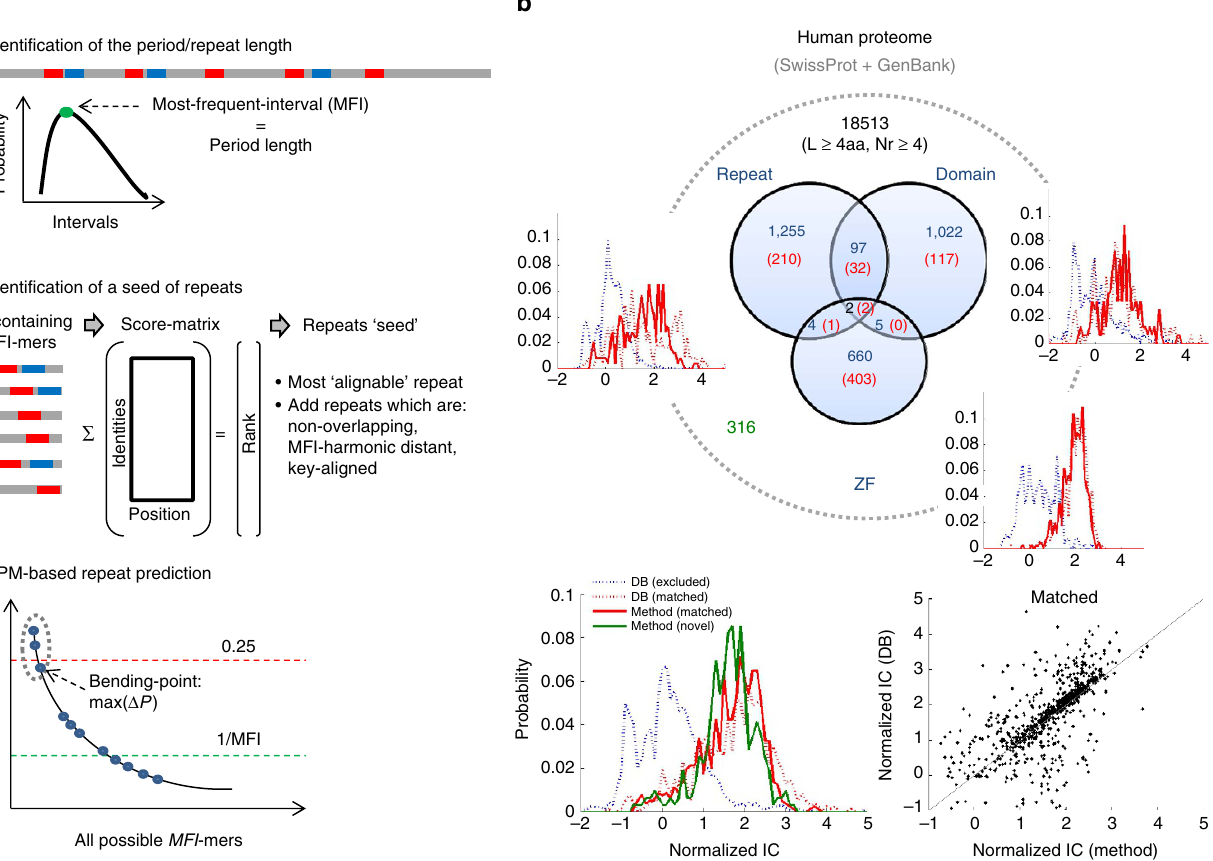
Figure 1 | Three steps computational pipeline to extract repeats and its validation. ( a ) First, the period length (L) of repeats is inferred from the most frequent interval (MFI) of frequent triplets (FT). Second, a seed of repeats is identified by aligning all possible k -mers ( k ¼ L ¼ MFI) that contain FT s , transforming the alignment into a scoring matrix, and selecting valid top ranked MFI-mers. Third, a probability position matrix (PPM), Q, is built from the seed over a background, B, to predict additional repeats. See Methods and Supplementary Methods for more details. ( b ) A set of 18513 canonical proteins from Swissprot that match information in GenBank, containing the corresponding coding DNA, are analysed. Swissprot annotates 3,045 proteins (blue numbers) which contain at least four repeats of length Z 4aa, assigned to 3 distinct classes (Repeats, Domains, Zinc-fingers). The method extracts a subset of 765 proteins (red) and identifies 316 novel ones (green), totaling 1,081 proteins with repeats. It excludes non-periodic and/or highly diverged repeats (blue dotted curves), and includes only repeats of identical length and high sequence similarity (red and green solid curves). Repeats in matched proteins (red numbers) have similar IC to the annotated repeats (red dotted versus red solid; and IC scatter